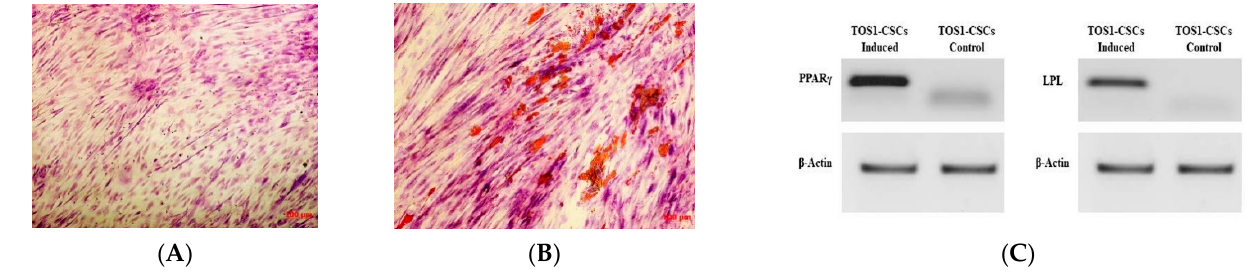
Figure 3 . Adipogenic differentiation assay and expression of adipogenic gene markers. Adipogenic differentiation at 0 days ( A ) and after 14 days ( B ) of induction by cytochemical staining with OIL Red O. Red shows the lipidic vesicles, violet shows the nuclei counterstained by hematoxylin. Observation is in brightfield. Original magnifications: 10×. ( C ) RT-PCR show the expression of PPAR γ (left) and of LPL (right) in TOS1-CSCs after 14 days of adipogenic induction.